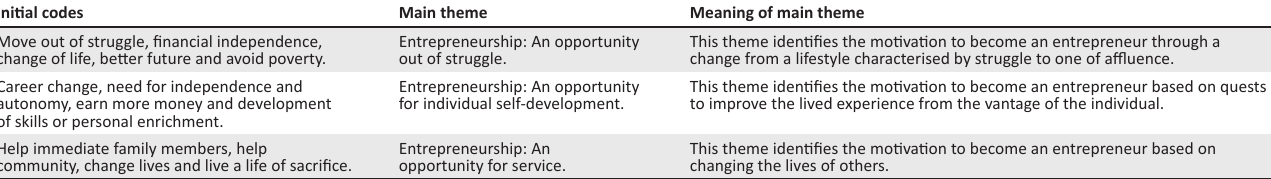
TABLE 4: Initial codes and main